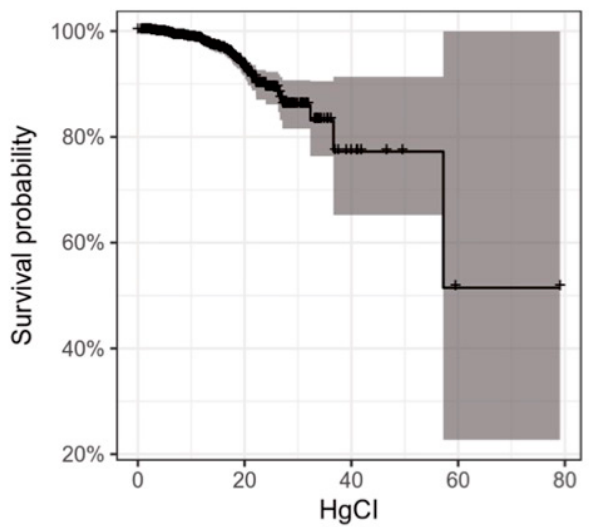
Figure 6. Graphic summary of the Kaplan–Meier analysis showing the competitive pressure as Hegyi competition index (HgCI) on the x -axis and the probability of survival on the y -axis for the third year after planting.